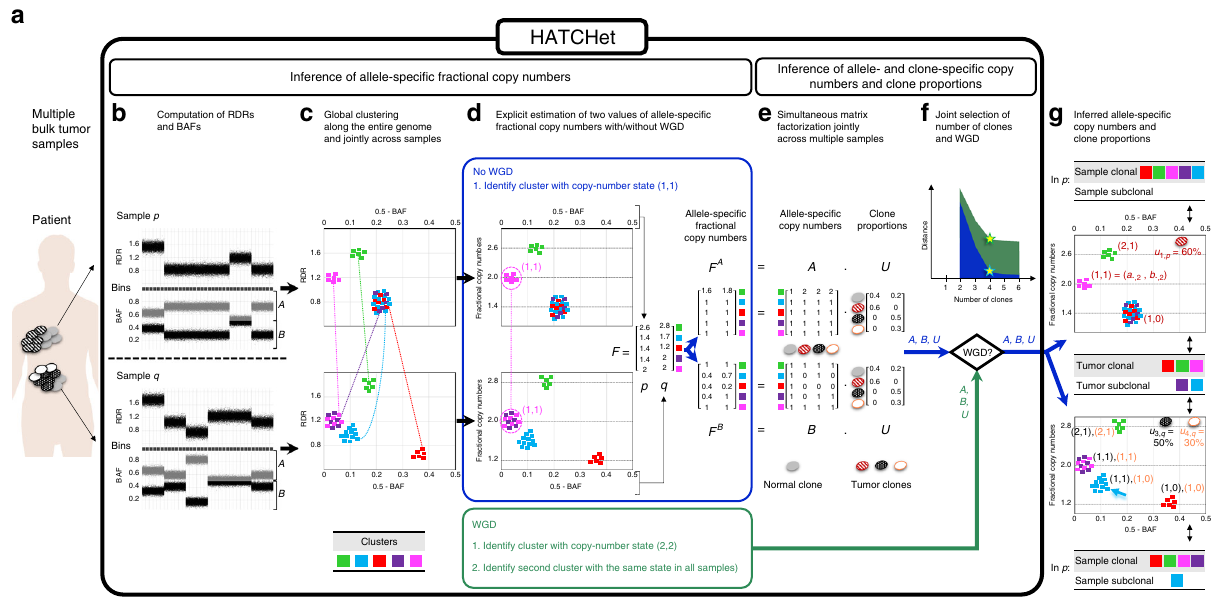
Fig. 1 Overview of HATCHet algorithm. a HATCHet takes in input DNA sequencing data from multiple bulk tumor samples of the same patient and has fi ve steps. b First, HATCHet calculates the RDRs and BAFs in bins of the reference genome (black squares). Here, we show two tumor samples p and q . c Second, HATCHet clusters the bins based on RDRs and BAFs globally along the entire genome and jointly across samples p and q . Each cluster (color) includes bins with the same copy-number state within each clone present in p or q . d Third, HATCHet estimates two values for the fractional copy number of each cluster by scaling RDRs. If there is no WGD, the identi fi cation of the cluster (magenta) with copy-number state (1, 1) is suf fi cient and RDRs are scaled correspondingly. If a WGD occurs, HATCHet identi fi es an additional cluster with identical copy-number state in all tumor clones. Dashed black horizontal lines in the scaled BAF-RDR plot represent values of fractional copy numbers that correspond to clonal CNAs. e Fourth, HATCHet factors the allele-speci fi c fractional copy numbers F A , F B into the allele-speci fi c copy numbers A , B , respectively, and the clone proportions U . Here, there is a normal clone and 3 tumor clones. f Last, HATCHet ’ s model-selection criterion identi fi es the matrices A , B , and U in the factorization while evaluating the fi t according to both the inferred number of clones and presence/absence of a WGD. g HATCHet outputs allele- and clone-speci fi c copy numbers (with the color of the corresponding clone) and clone proportions (in the top right part of each plot) for each sample. Clusters are classi fi ed according to